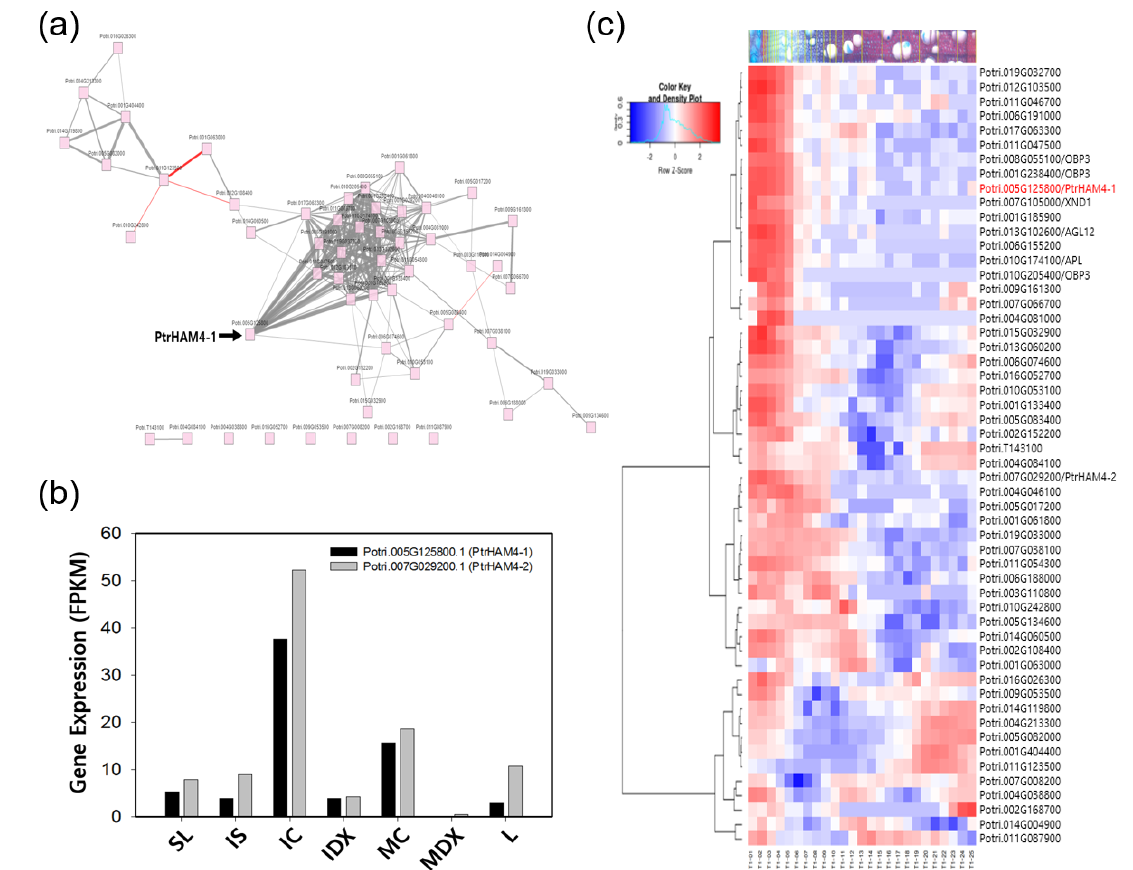
Figure 6. Identification of PtrHAM4-1 , preferentially expressed in cambium tissue based on in Silico analysis. ( a ) Co-expression network of the intermediate cambium (IC) tissue preferentially expressed transcriptional regulators. The co-expression network was obtained from the AspWood website (http: // aspwood.popgenie.org / aspwood-v3.0 / ) by querying a total of 64 poplar genes (Potri. ID) in the Table 2. PtrHAM4-1 (Potri.005G125800) was relocated to emphasize. ( b ) Tissue-specific expression of both Potri.005G125800.1 / PtrHAM4-1 and its closest homolog, Potri.007G029200.1 / PtrHAM4-2 . This